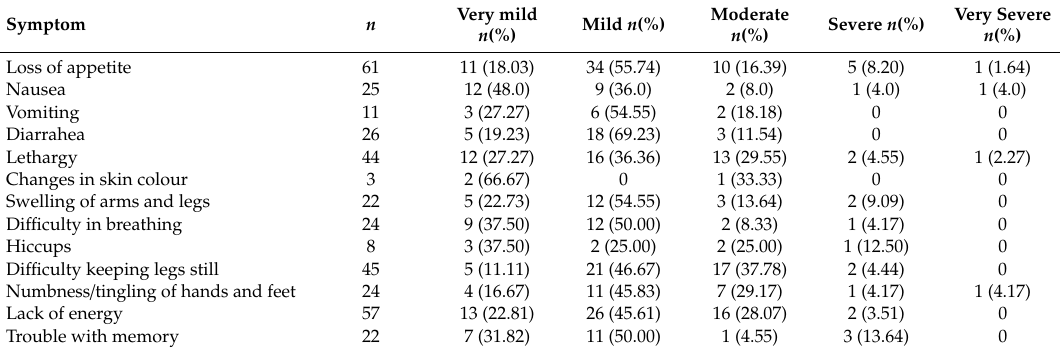
Table 3. Intrusiveness of symptoms perceived by the study